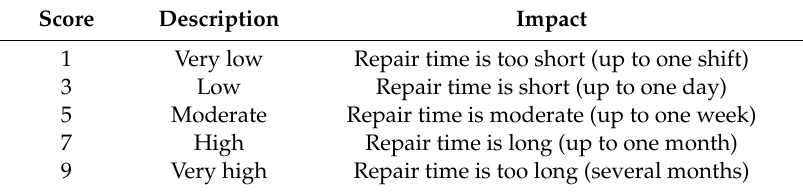
Table 4. Mean Time to Repair (MTTR) Impact Scores and